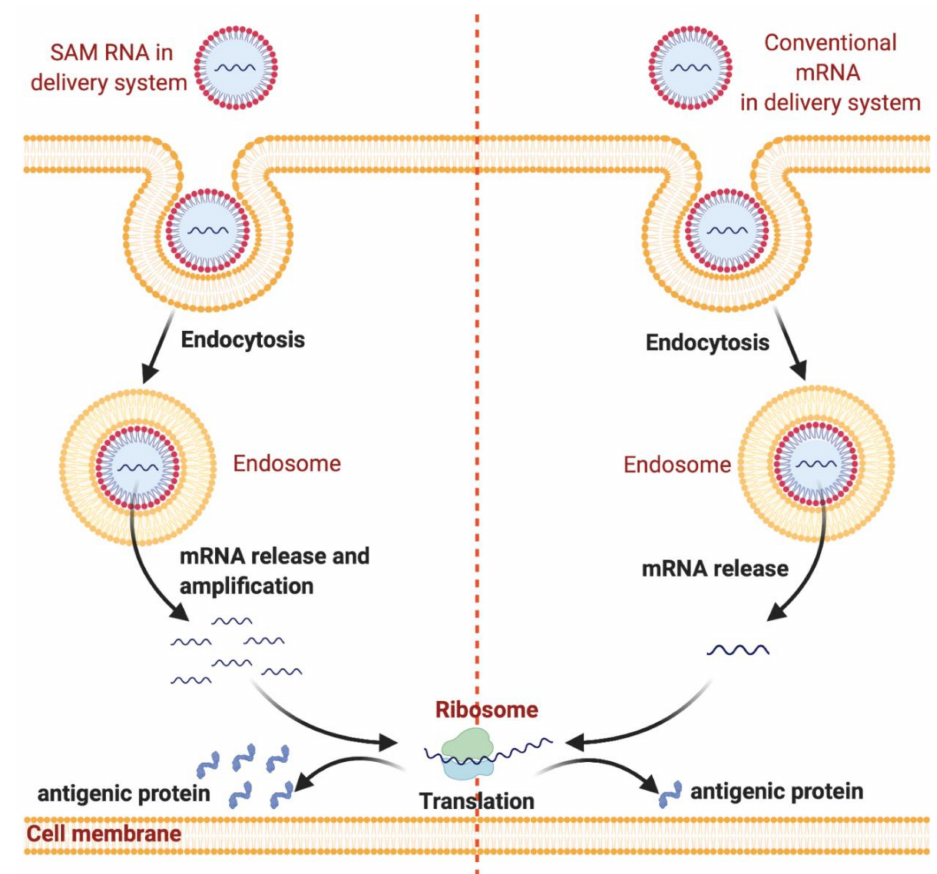
Figure 1. Nanodelivery systems protect messenger RNA (mRNA) from degradation and enhance endocytosis and endosomal escape. mRNA can be loaded into nanodelivery systems for protection from enzymatic degradation. After administration, mRNA is internalized by dendritic cells through endocytosis followed by endosomal escape. Subsequently, mRNA is released into the cytosol, which is followed by mRNA translation into antigenic protein by ribosomes. The figure was created using